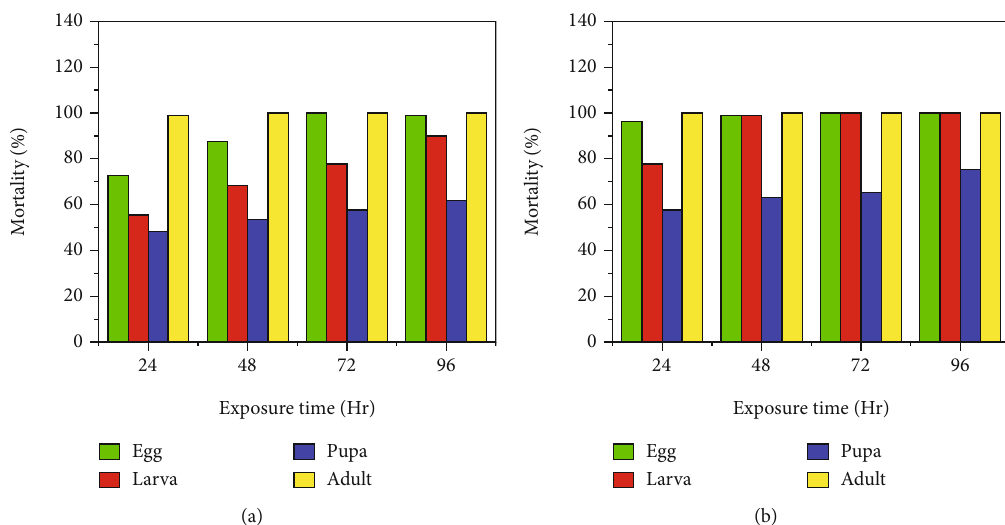
Figure 6: Mortality of Callosobruchus maculatus egg, larva, pupa, and adult at (a) 50% CO